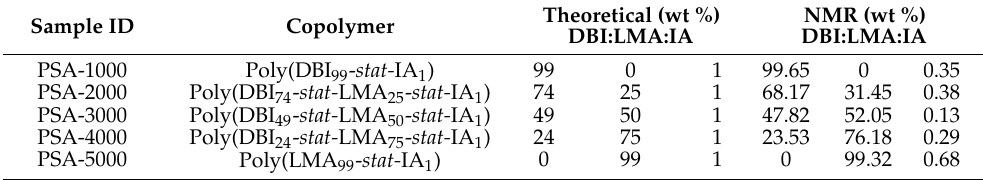
Table 2. Comparison of theoretical vs. NMR ratios.